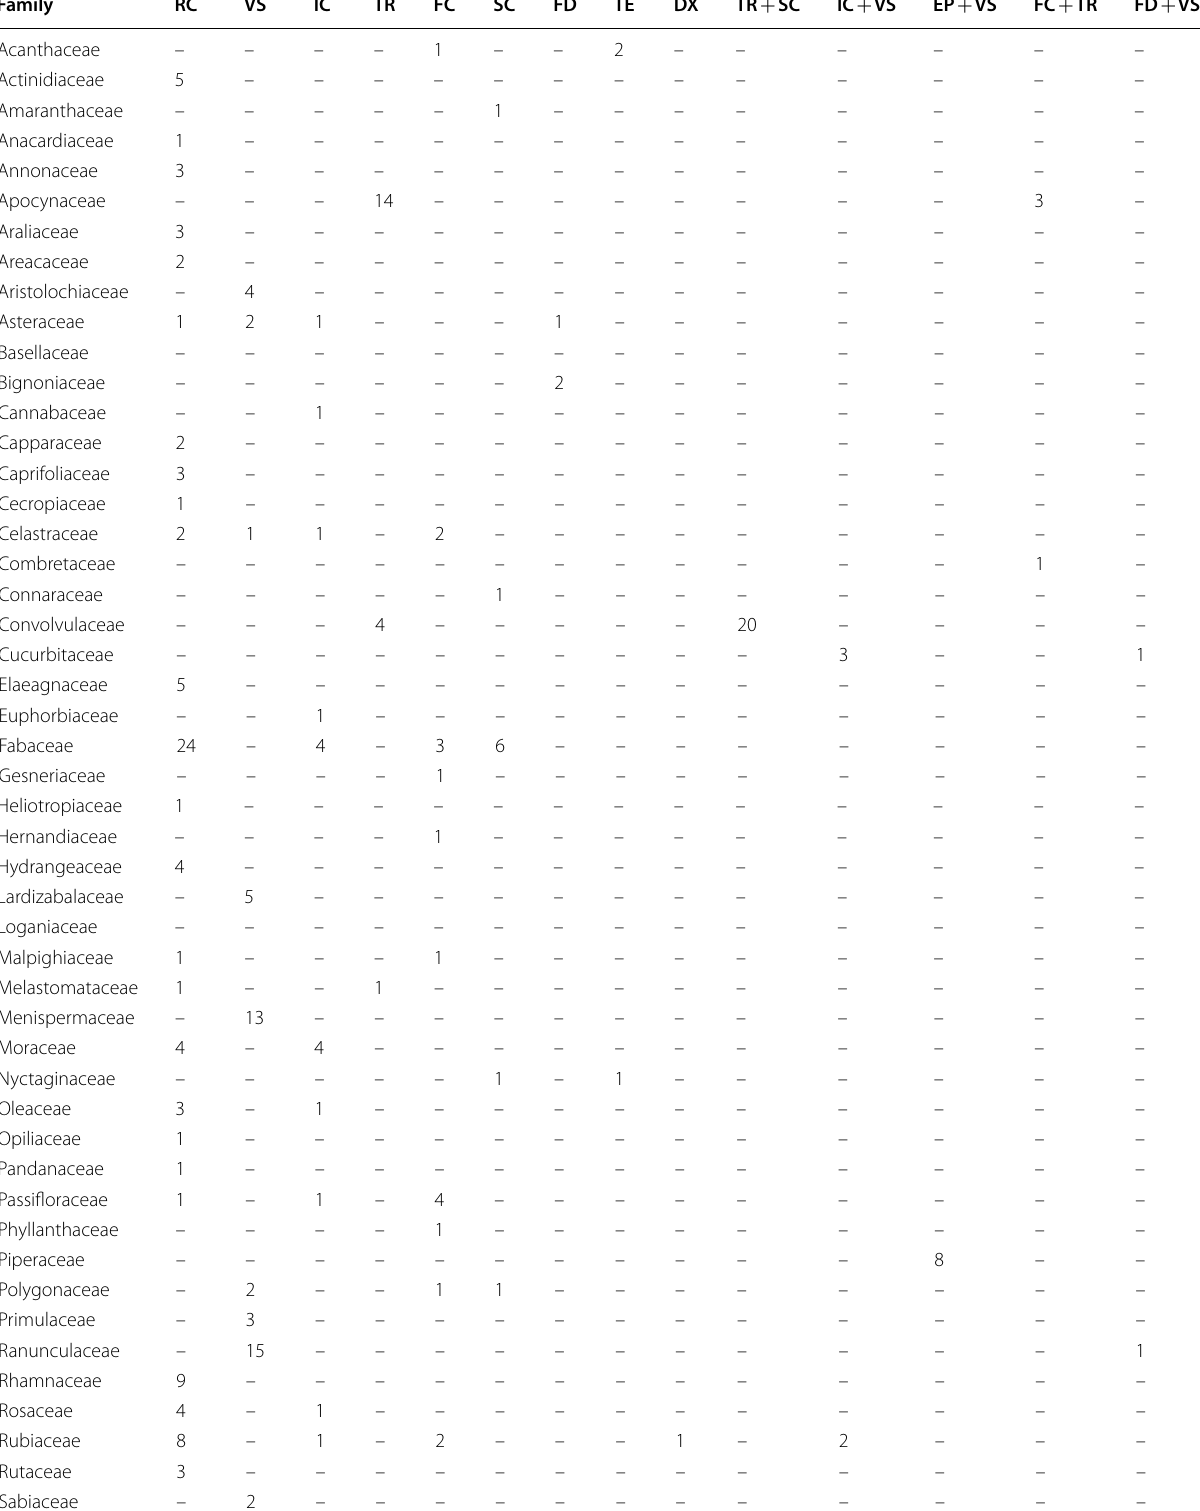
Table 2 Cambial variant types of lianas of different families in Taiwan Family RC VS IC TR FC SC FD TE DX TR